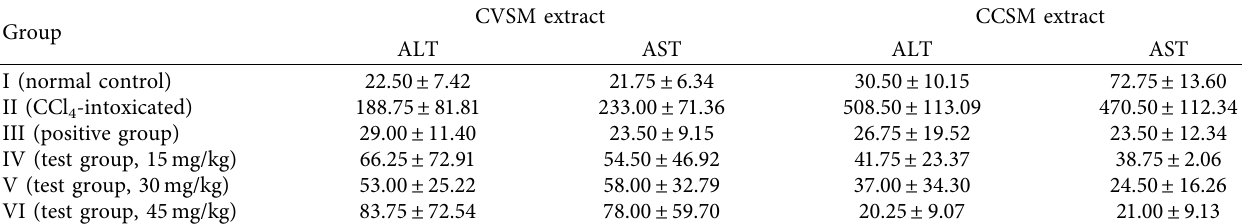
4 -induced toxicity of liver in